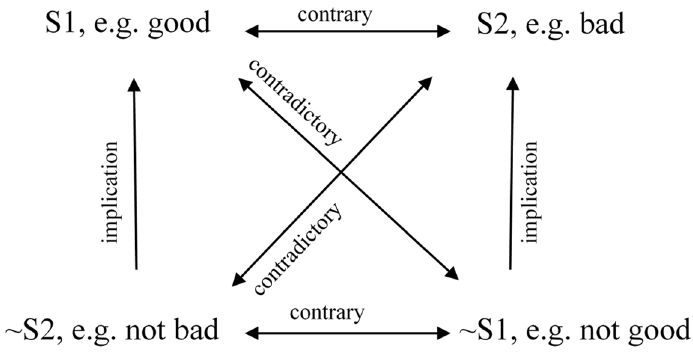
Figure 2. The semiotic